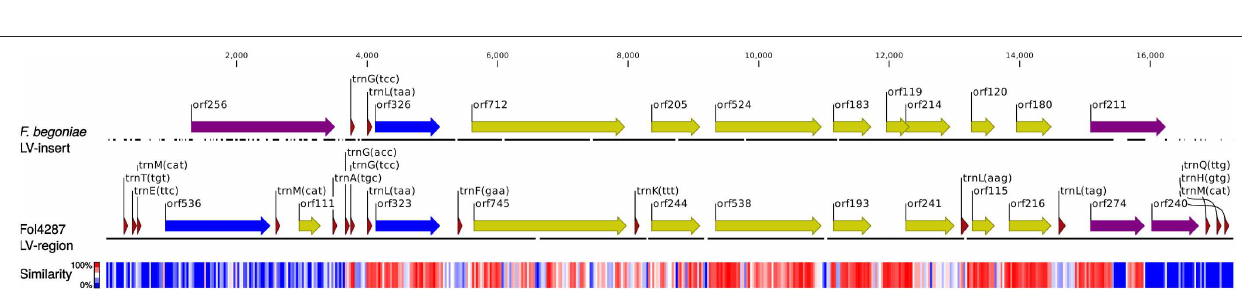
FIGURE 4 | Alignment between the insert in the LV region of F. begoniae and variant 2 of F. oxysporum Fol4287. Black lines: aligned sequences, gaps in the alignment are shown as gaps in the black lines; red triangles: tRNA genes; yellow arrows: ORFs; blue arrows: LAGLIDADG endonucleases; purple arrows: GIY-YIG endonucleases. Sequence similarity is indicated in color scale based on 30 bp segments. The scale above indicates position within the